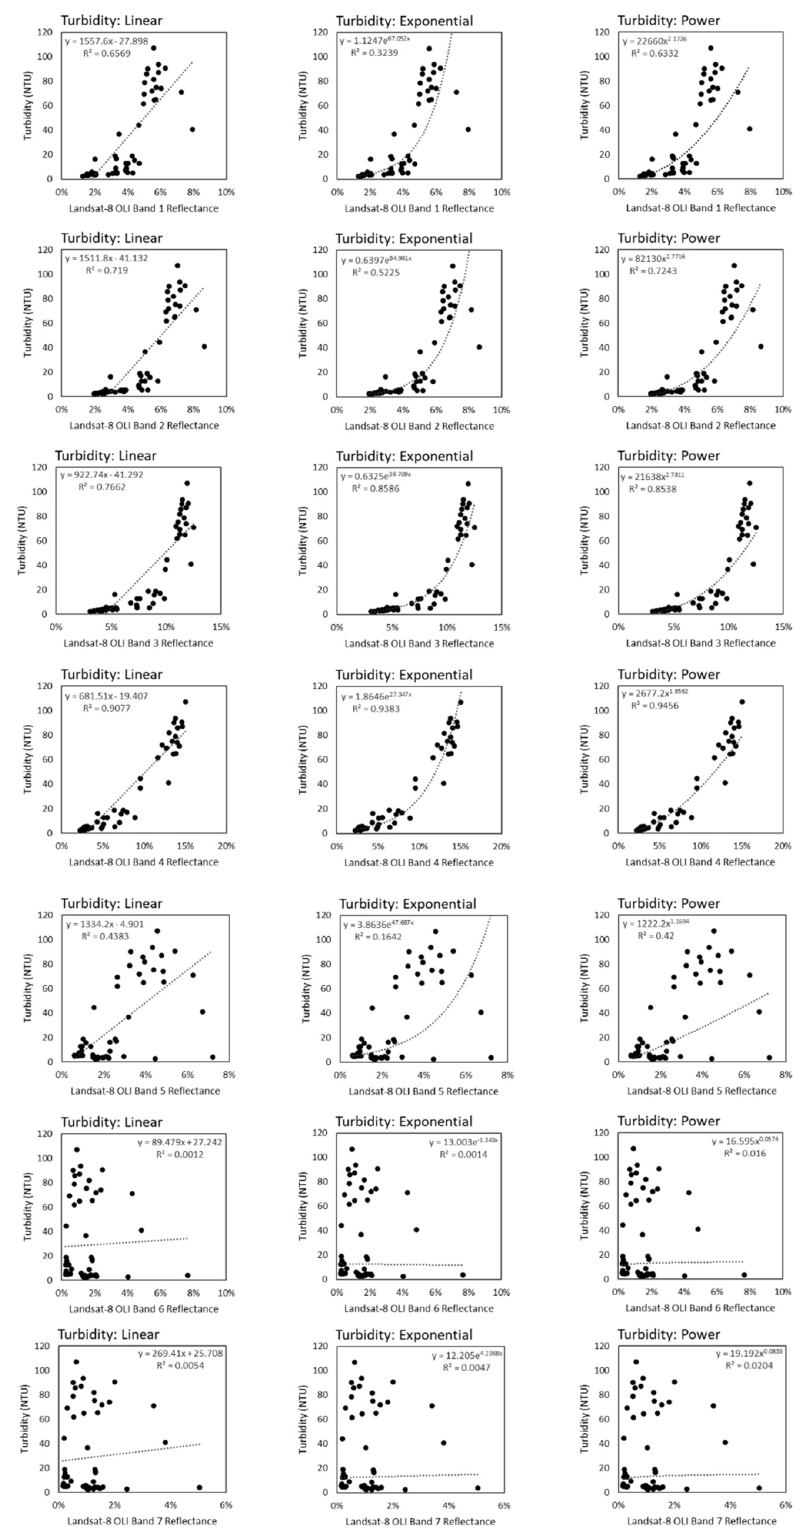
Figure 7. Regression scatterplots for all bands: linear regressions ( left ); nonlinear exponential regressions ( middle ); nonlinear power regressions ( right